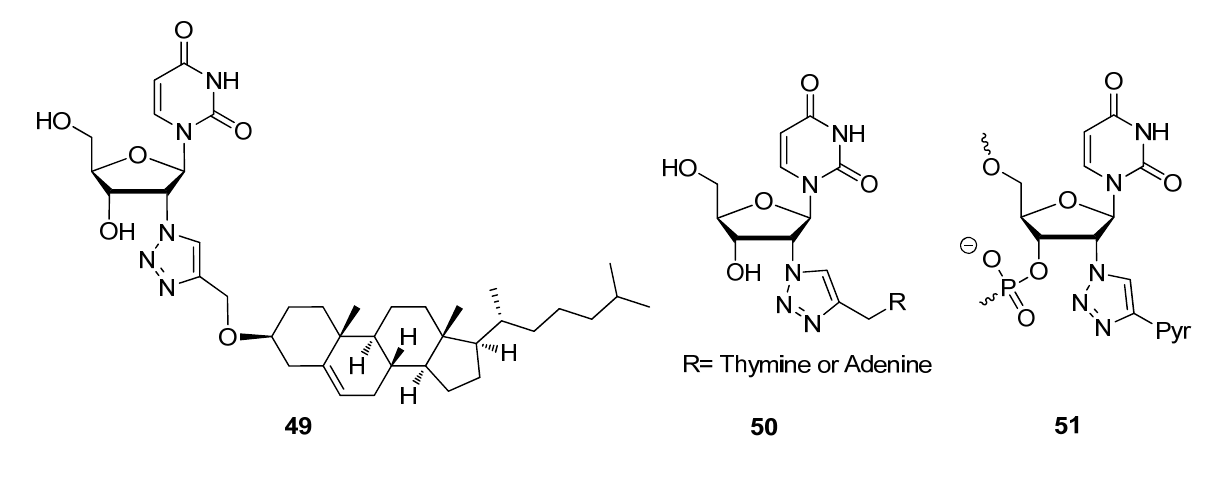
Figure 8. Structures of C2 ′ -triazole modified